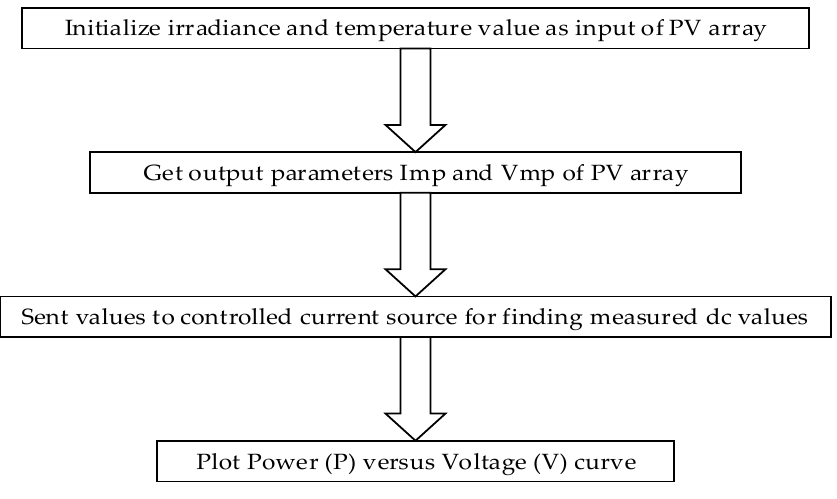
Figure 2. Algorithm for P-V curve analysis.